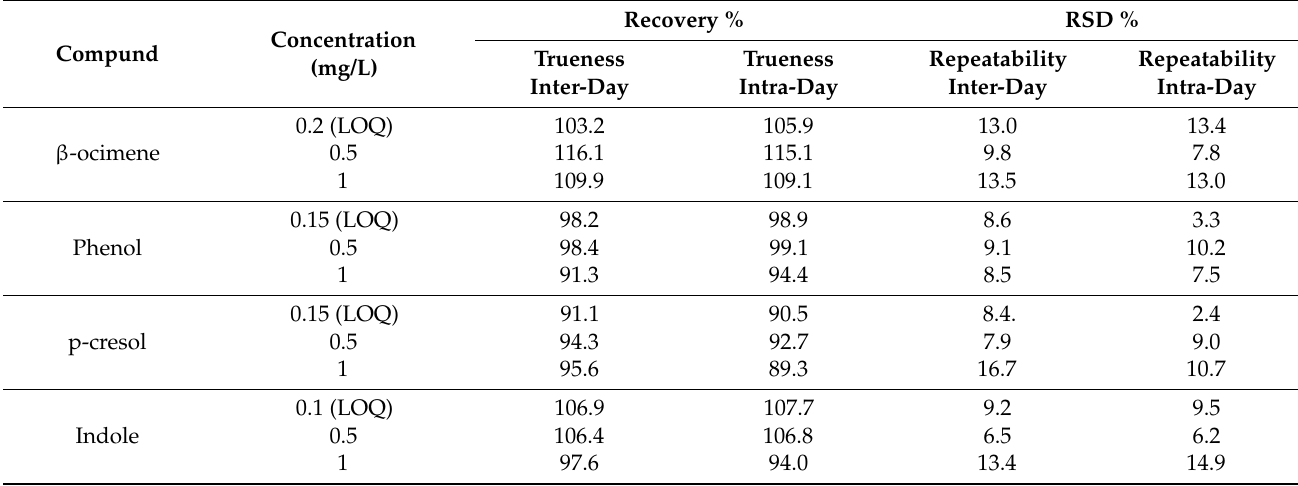
Figure 8. Scheme of the HS-GC/MS methodology used for the study of the controlled release of the microencapsulated bioattractants. Step 1: liquid-gas equilibrium stage. Step 2: gas equilibration time, Step 3: gas goes ahead the transfer line to the gas chromatograph, Step 4: separation of the analytes from the sample on chromatographic column and quantification of the analytes. Table 3. Validation parameters of HS-GC/MS method used for the study of the controlled release of the microencapsulated